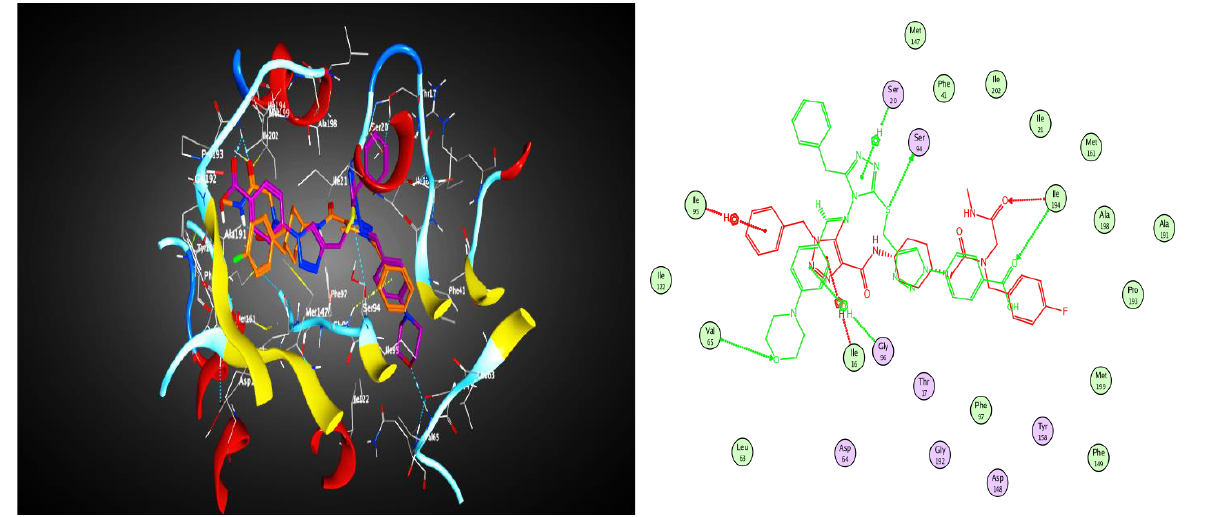
Figure 12. An overlay of the docked pose of compound 7e (brown) with Lead structure B (purple) into inhA active site in 2D (right panel) and 3D (left panel).